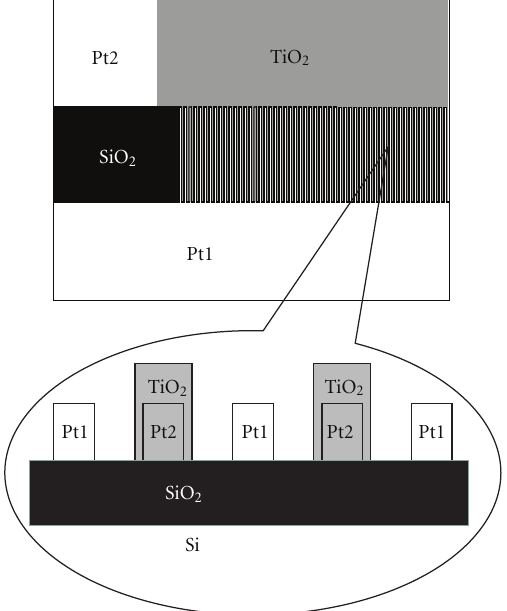
Figure 1: Schematics of an interdigitated device (not to scale). The titanium dioxide part is in gray, the insulating (SiO 2 ) area is in black, and the platinum electrodes and connectors are in white.